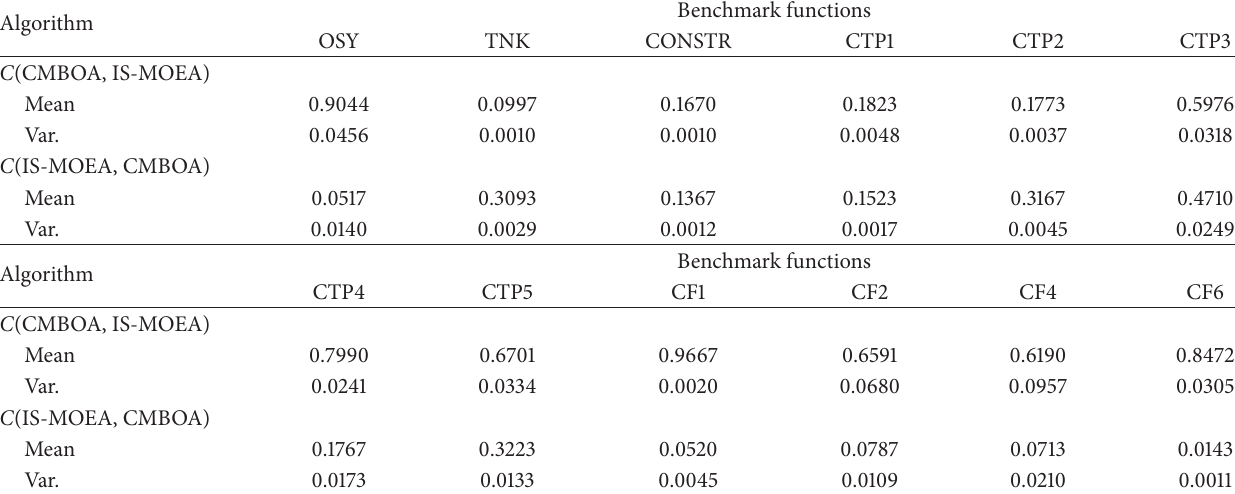
Table 4: Mean and variance (Var.) of the cover metric on CMBOA and